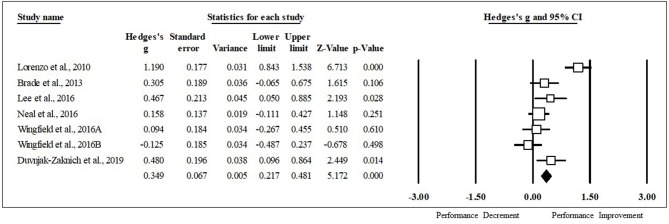
Mean power forest plot. Data are presented as Hedge's g and 95% confidence intervals.